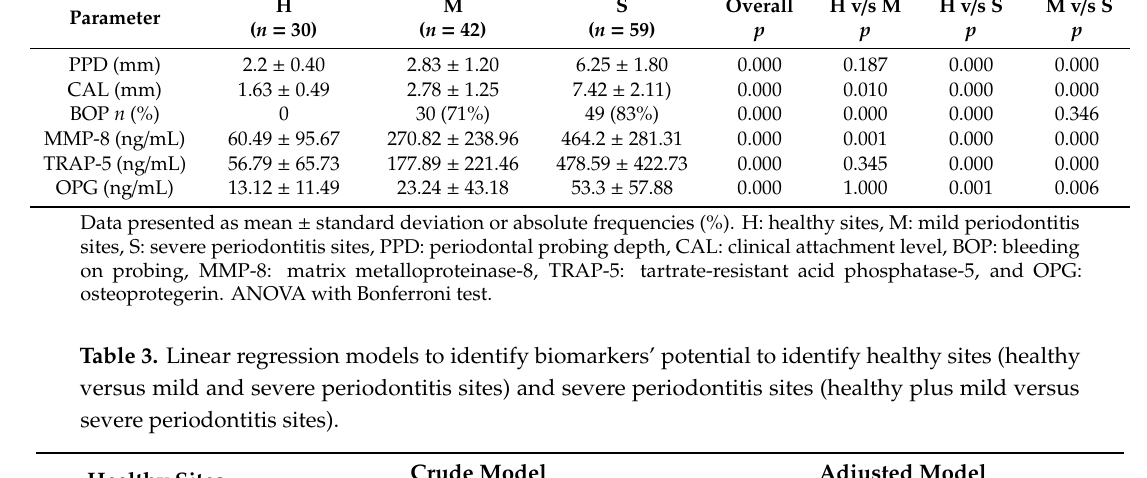
Table 2. Clinical parameters and levels of biomarkers in healthy, mild, and severe periodontitis sites. Parameter